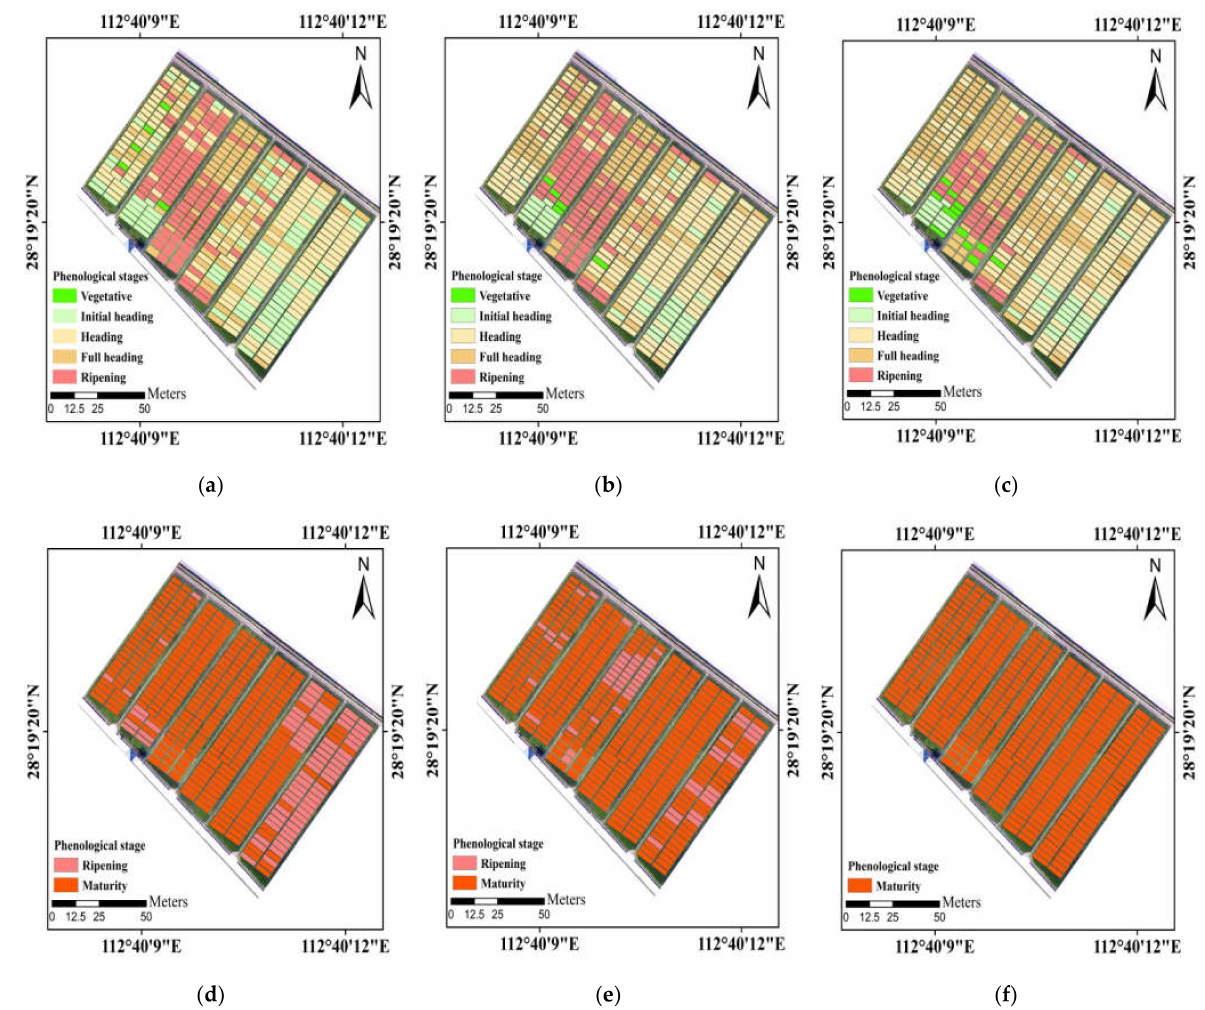
Figure 9. Maps of principal phenological stages obtained from the visual observation ( a , d ), the predictions of soft voting ( b , e ) and GNB ( c , f ) in the study area. The UAV flights were carried out on ( a – c ) 11 September 2020 and ( d – f ) 1 November